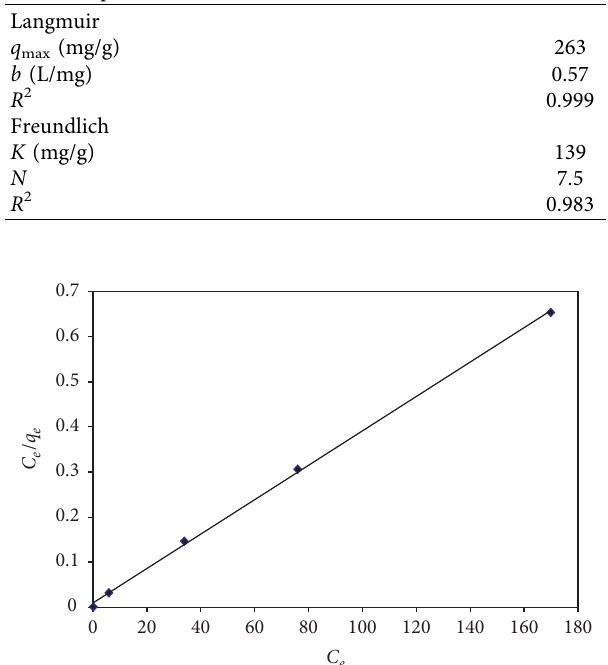
Figure 8: Langmuir adsorption isotherm of CV onto Khulays’ natural bentonite.